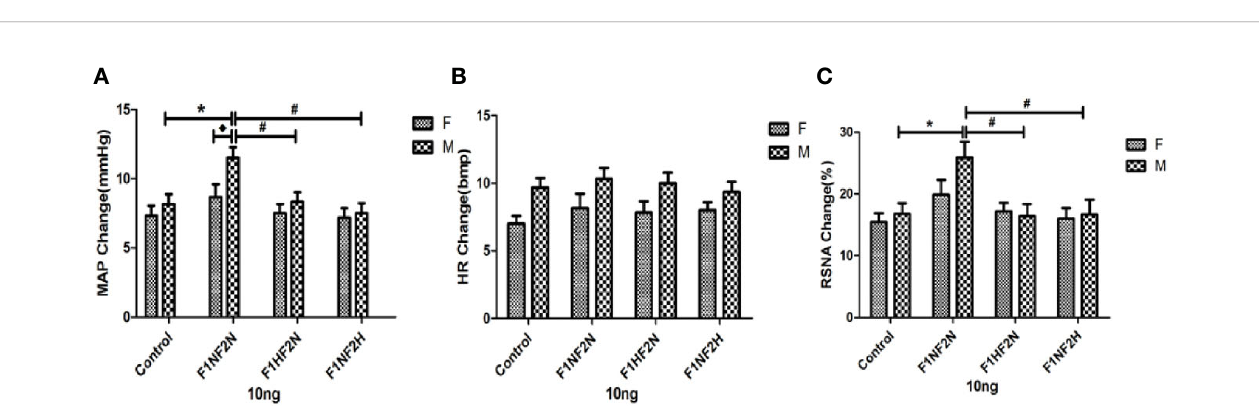
FIGURE 1 | A raw trace recordings showing microinjection of Ang II (10 ng, 5 m L) into the lateral ventricles (LVs) of rats increased mean aterial pressure (MAP), HR, and renal sympathetic nerve activity (RSNA) in male offspring from the control, F 1N F 2N (offspring of renovascular hypertension [RVH] rats), F 1H F 2N (RVH rats treated with NaHS, offspring without NaHS), and F 1N F 2H (maternal RVH rats treated without NaHS and offspring with NaHS after weaning) groups ( n = 8).